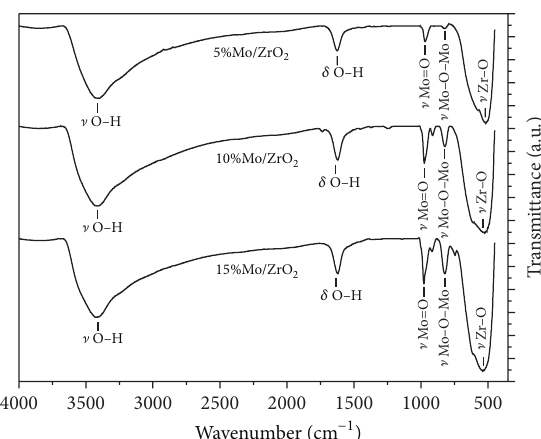
Figure 10: Pore size distribution of ZrO 2 .